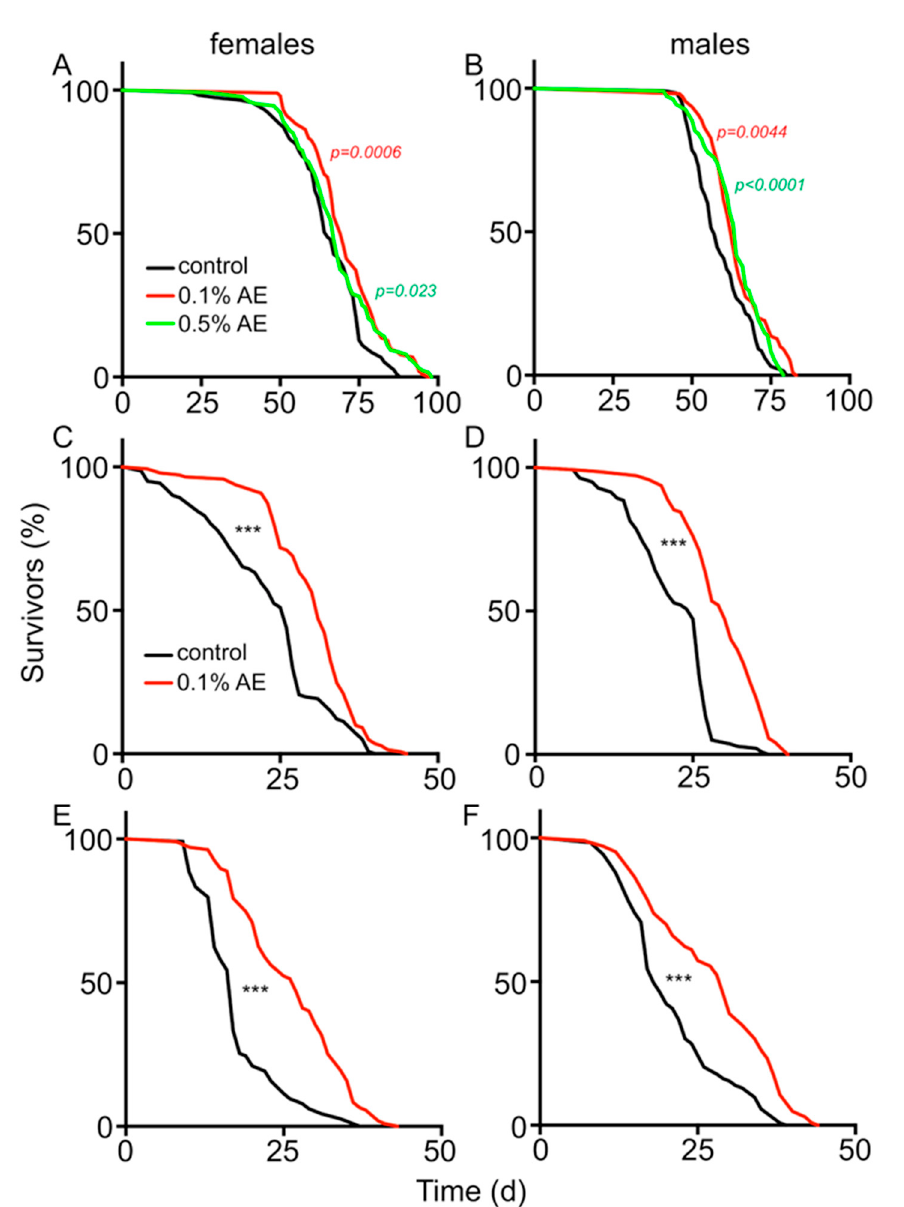
Figure 1. Lifespans of female ( A ) and male flies ( B ), subjected to normal food (black line), normal food supplemented with 0.1% brown algae extract (BAE) (red line), or 0.5% BAE (green line), were quantified. Lifespan analyses of female ( C , E ) and male flies ( D , F ) on control food (black lines) or on normal food supplemented with 0.1% BAE (red lines). Food was additionally supplemented with 10% triglycerides for the entire time of the experiment ( C , D ) or just for the first 10 days, where after flies were transferred to corresponding media without additional fat ( E , F ). Statistical analyses were done using a log-rank test. n > 100, *** means p < 0.001.